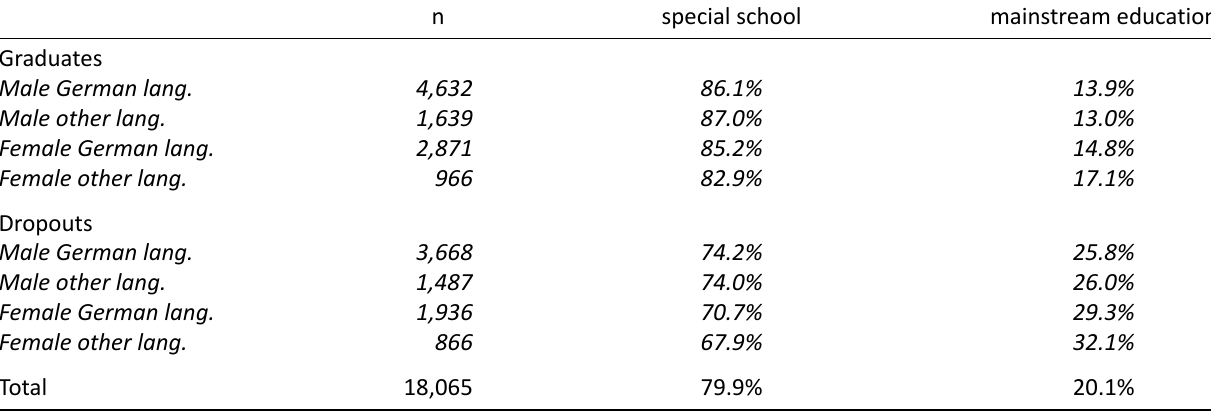
Table 3. Share of students enrolled in a special school vs. mainstream education.